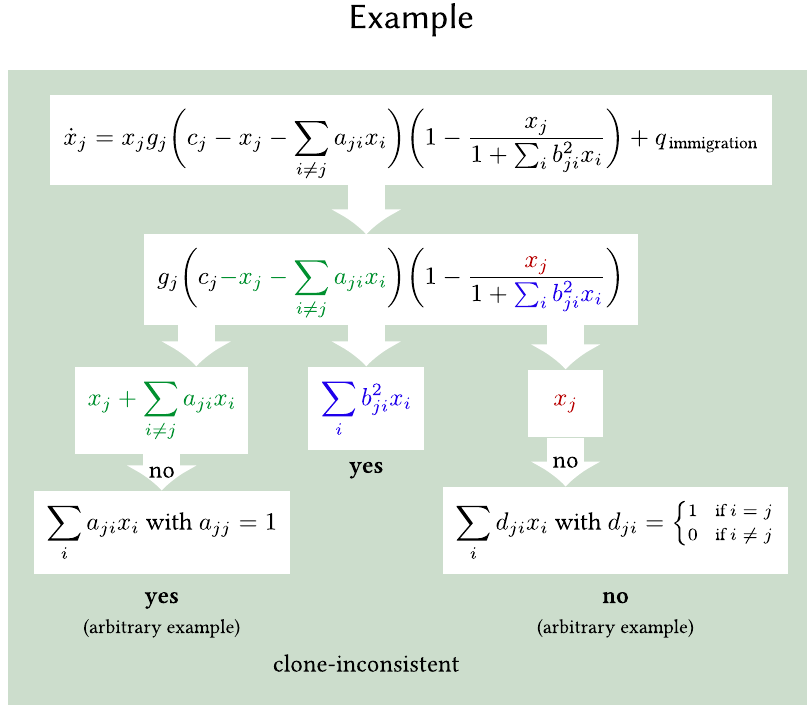
, b , c , and d are parameters i i i i